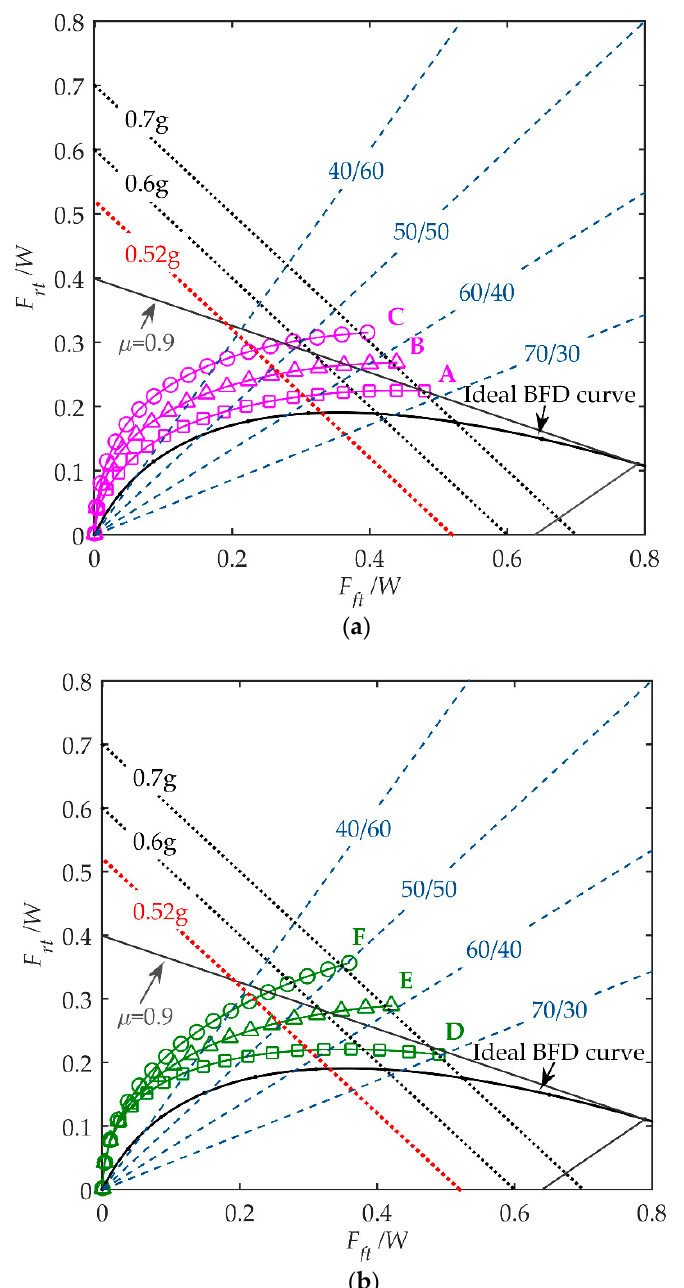
Figure 9. The BFD curves of different spring rates matching with the new designed cam profile. ( a ) Curves A~C: k s 1 = 4, 8, 12 N/mm with k s 2 = 0.08 N/mm 3 ; ( b ) curves D~F: k s 2 = 0.06, 0.09, 0.14 N/mm 3 with k s 1 = 8 N/mm .